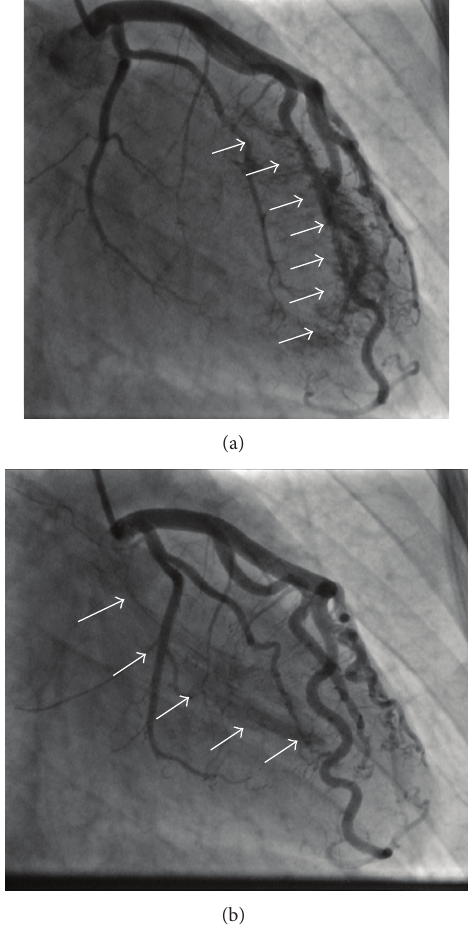
Figure 2: ((a), (b)) Selective coronary angiography shows multiple fistulae from the distal left anterior descending coronary artery and diagonal braches to the left ventricle (arrows).